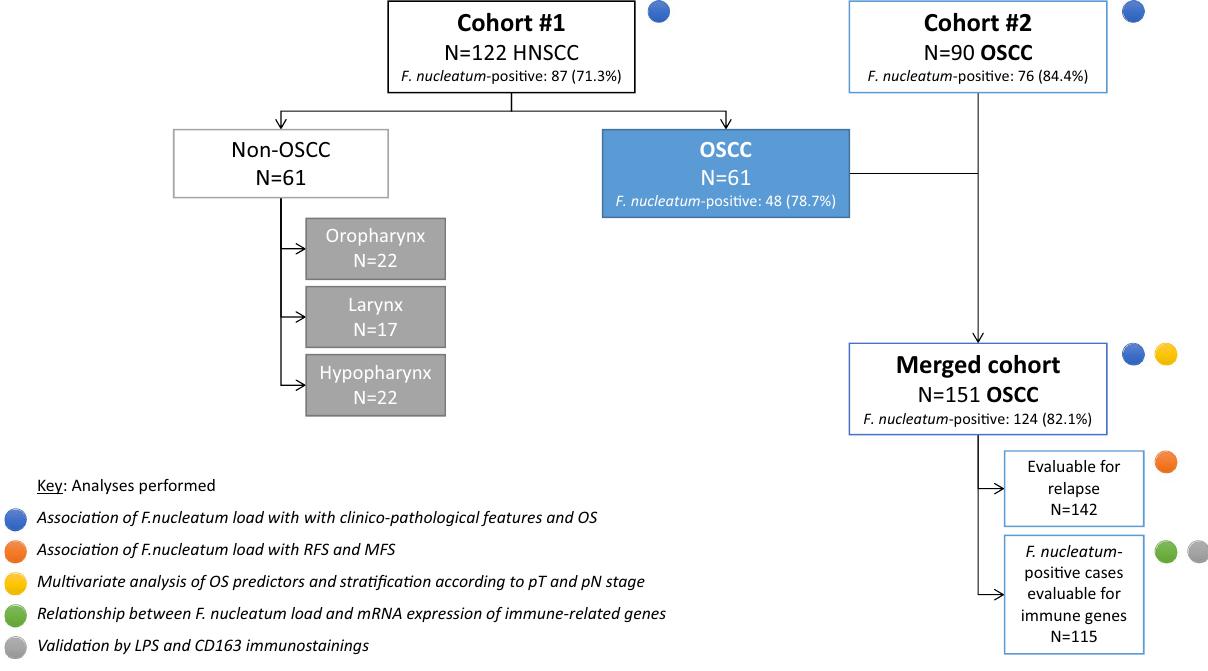
Figure 1. Patient